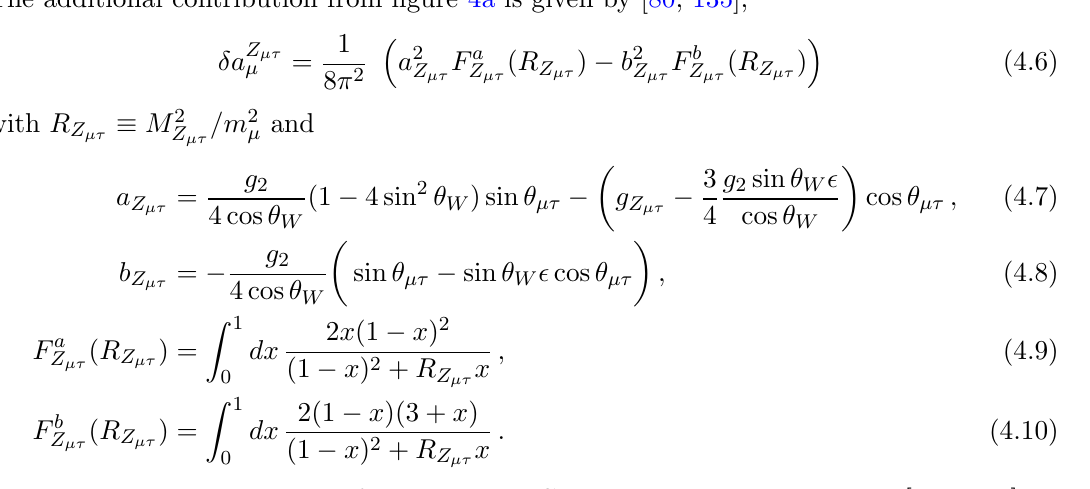
Figure 4 . Relevant penguin diagrams that are contributed to the ( g model, 13 apart from the SM contribution, we have two additional one loop diagrams (see (cid:12)g- ure 4) in which the extra neutral gauge boson Z (cid:22)(cid:28) and extra CP-even scalar H 2 are involved. The additional contribution from (cid:12)gure 4a is given by [80,